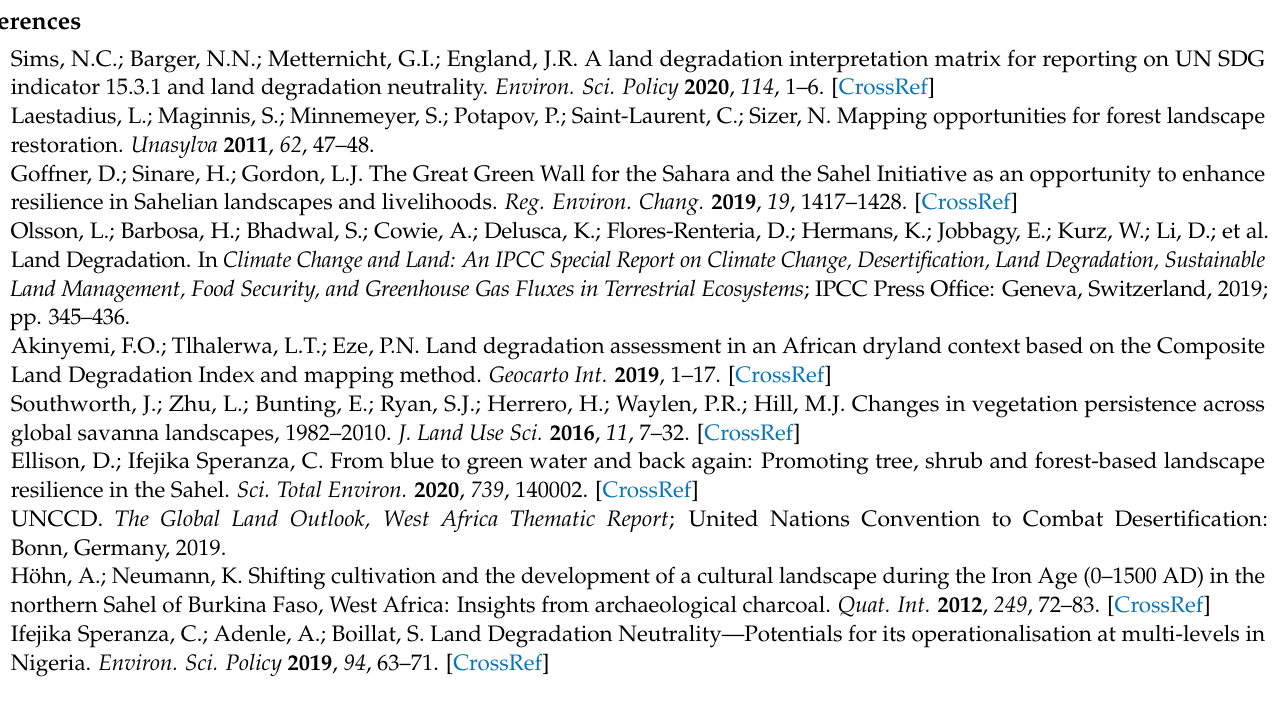
archetypes, Figure S2: Training process for determining the nine cluster separations that are suitable for the land-degradation archetypes, Figure S3: The plot showing the aggregated profile of each neuron as synthesized by the selected drivers of land degradation, Figure S4: Quality of the nine clusters in the codebook, Figure S5: Neighbor distances between the neurons for the clusters, Table S1: Calculated Z-score normalized values of drivers characterizing the nine (9) distinctive archetypes of land degradation, Table S2: Archetypes and percentage share per state administration unit, Table S3: Archetypes and share of land